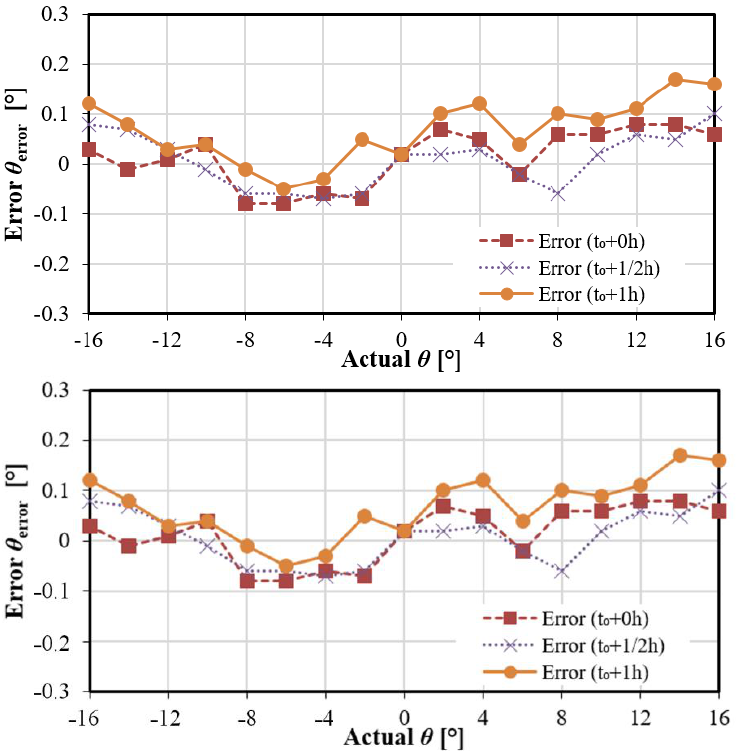
Figure 9. Calibration robustness versus operating time. Calibration done once at t 0 . Accuracy remains stable even after 1 h without recalibration. The supply is nominal, i.e., 1.8 V.